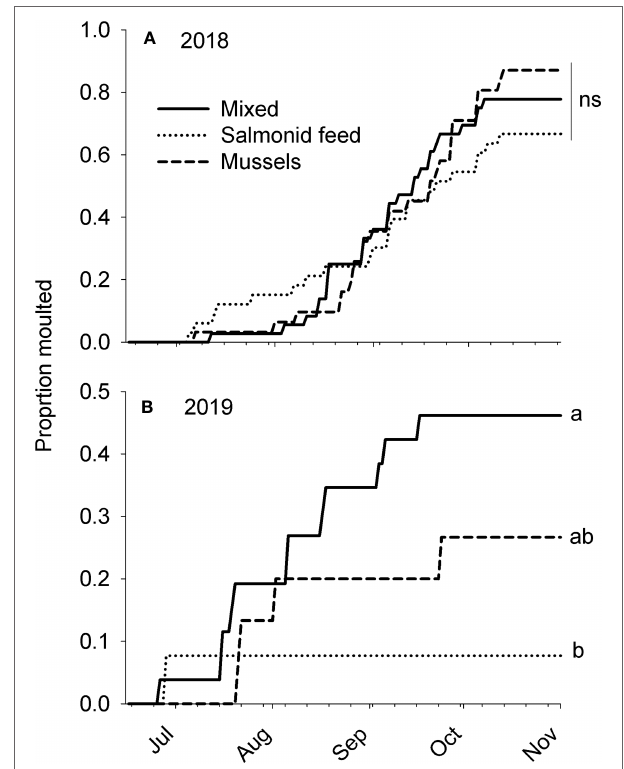
FIGURE 3 | Moulting of rock crabs Cancer irroratus fed different aquaculture- related diets in a laboratory experiment in (A) 2018 and (B) 2019. Proportion not moulted was analyzed through survival analyses, but proportion moulted is presented. Lines not sharing a common letter are significantly different (Holm-Sidak post-hoc test), ns = not significant. The number of individuals included in the analysis in 2018 was 36, 33, and 31 for the mixed, salmonid feed and mussel diets, respectively and, in the same order, 26, 13, and 15 in 2019.